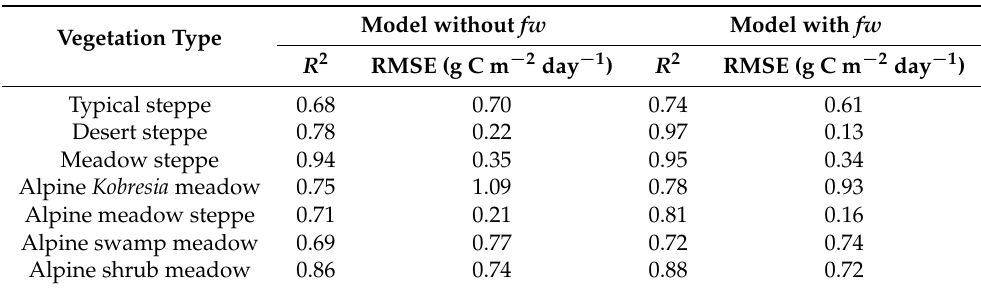
Table 5. Comparison of model performance between the model without fw and the model with fw for each vegetation